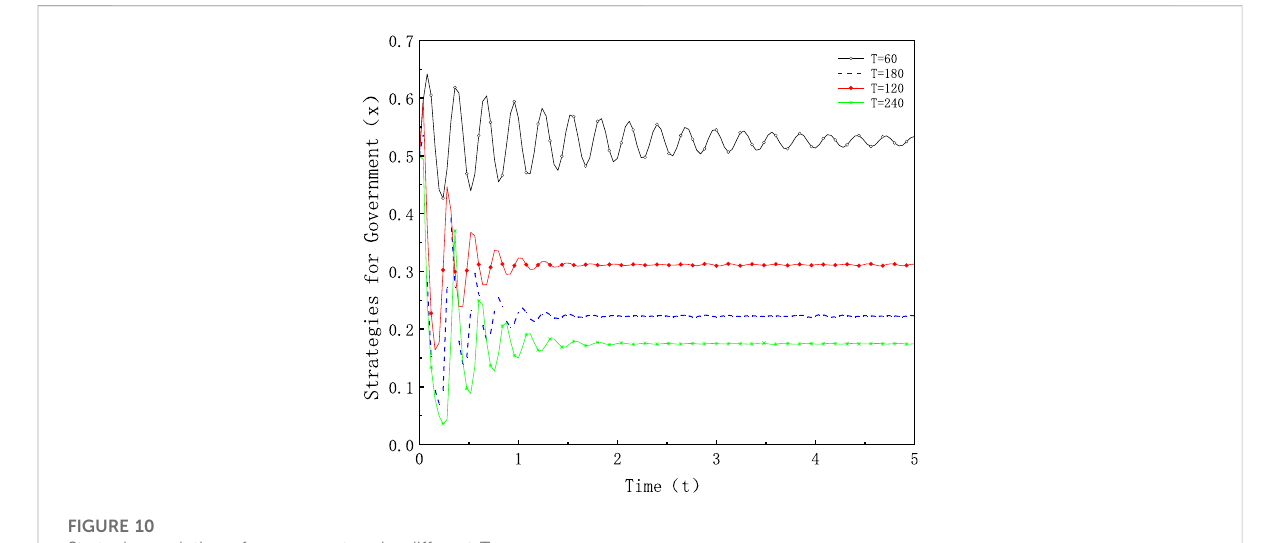
FIGURE 10 Strategies evolution of government under different T